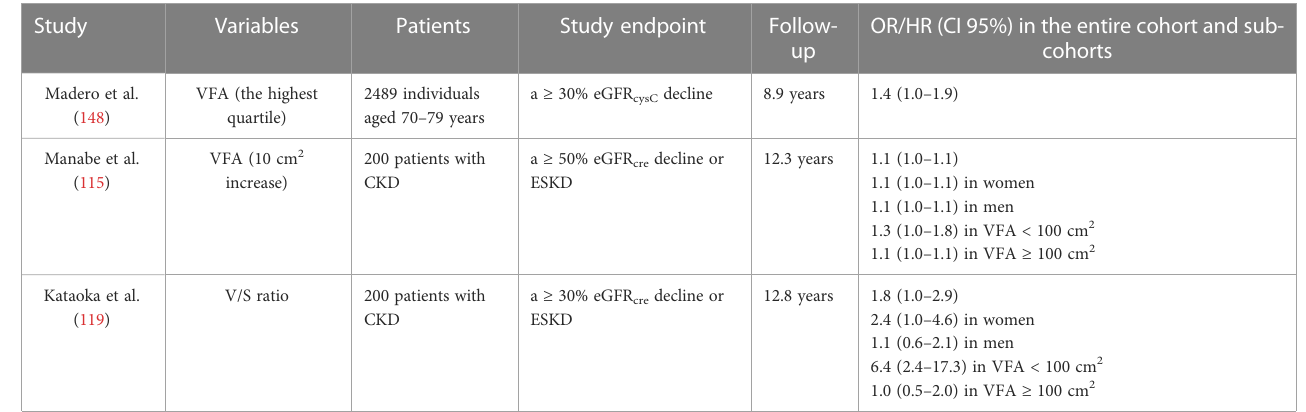
TABLE 1 Risks of visceral fat indicators for CKD